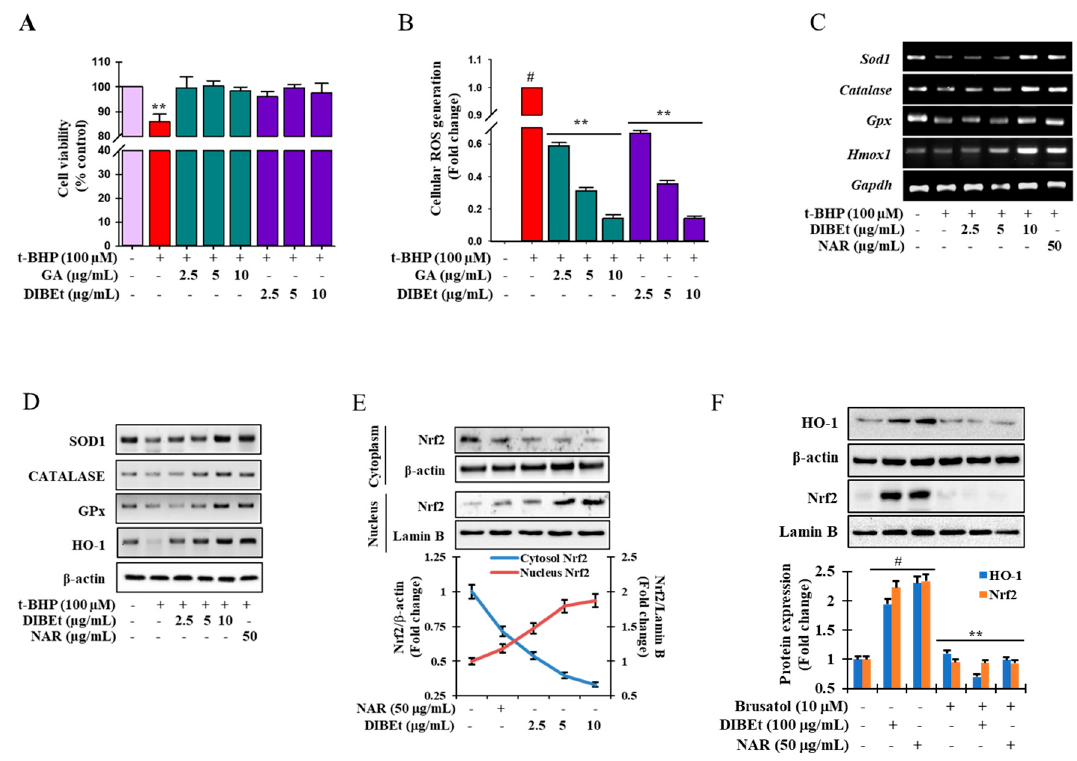
Figure 4. Protective effects of DIBEt against t-BHP-induced cell toxicity and intracellular ROS generation through the up-regulation of antioxidant enzymes via Nrf2 activation. Cells were treated with DIBEt and gallic acid (GA) at the indicated concentrations for 12 h and then exposed to 100 μ M t-BHP for 6 h. Cell viability percentage ( A ) and intracellular ROS ( B ) were determined by MTT assay and the DCFH-DA method, respectively. Mean ± SD ( n = 3). # p < 0.001, compared to no treatment; ** p < 0.05, compared to t-BHP treatment. SOD1, catalase, GPx, and phase II antioxidant enzyme (such as HO-1) mRNA ( C ) and protein expression ( D ) were analyzed by RT-PCR and Western blot, respectively. Nrf2 protein expression ( E ) was measured by Western blot. Cells were treated with an Nrf2 inhibitor (brusatol) with and without DIBEt and naringenin (NAR). Nrf2 and HO-1 protein levels were analyzed by Western blot ( F ). Mean ± SD ( n = 3). # p < 0.001, compared to no treatment; ** p < 0.05, compared to sample treatment. (+): presence; (-): absence.